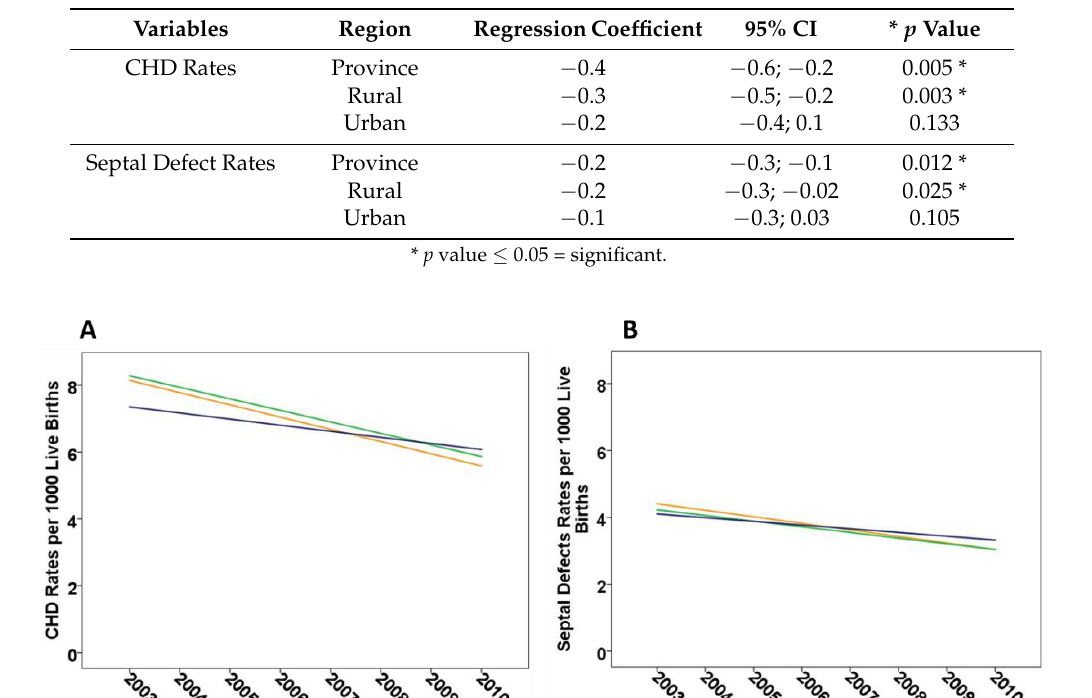
pulmonary vein stenosis (1). Table 2. Trends of CHD and septal defects rates for exposure years 2003–2010 in Alberta and its urban and rural regions.